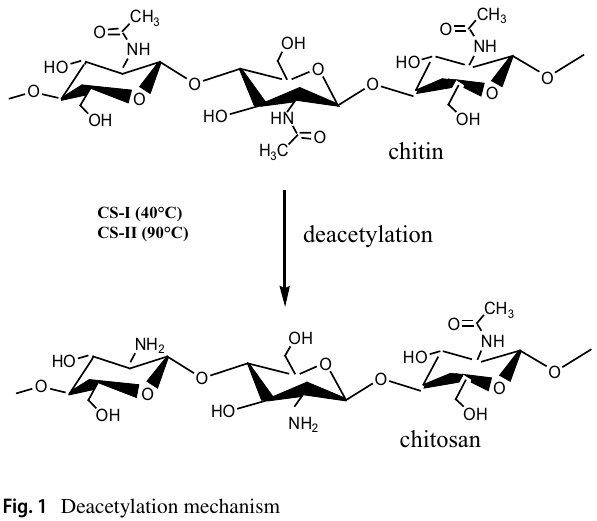
Fig. 1 Deacetylation